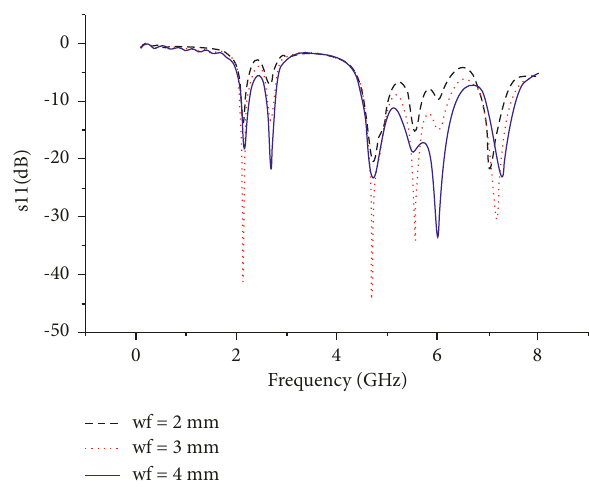
Figure 9: S 11 for various feed